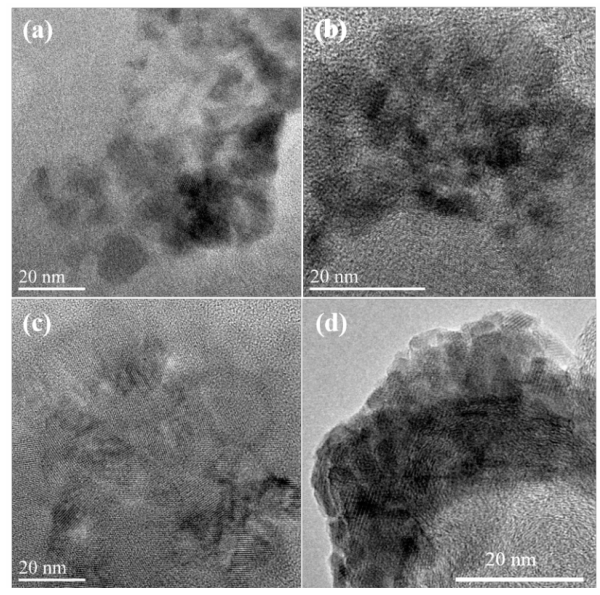
Figure 3. Transmission electron microscopy (TEM) images of as-prepared ( a ); CoS-250 ( b ); CoS-300 ( c ); and CoS-400 ( d ).